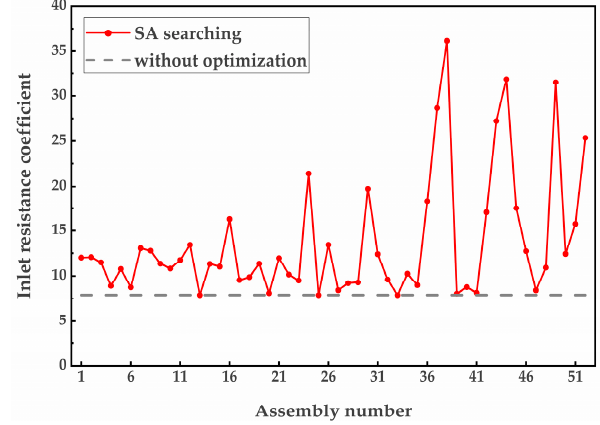
Figure 4. Inlet resistance coefficient of optimal solution.